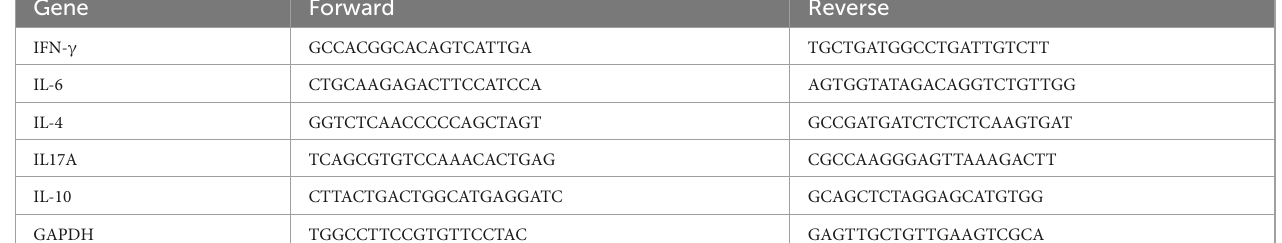
TABLE 1 Primers used in real-time PCR.